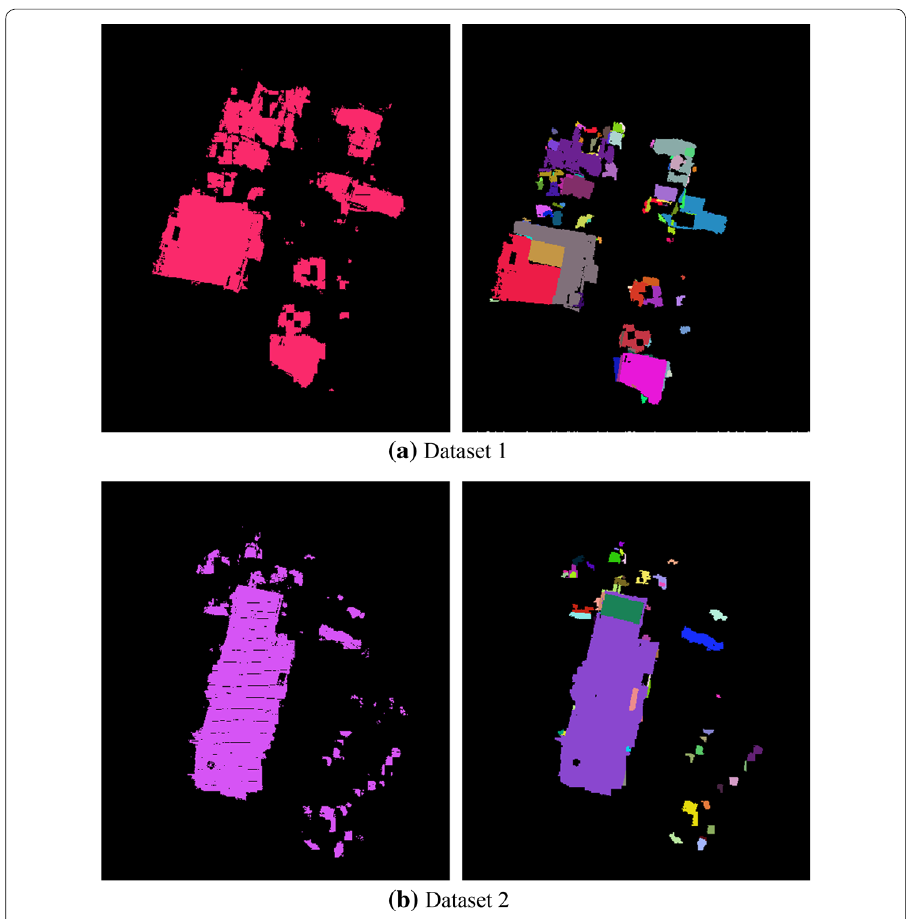
Fig. 7 Visualization of building segmentation using the Euclidean Distance (Dataset 1 and